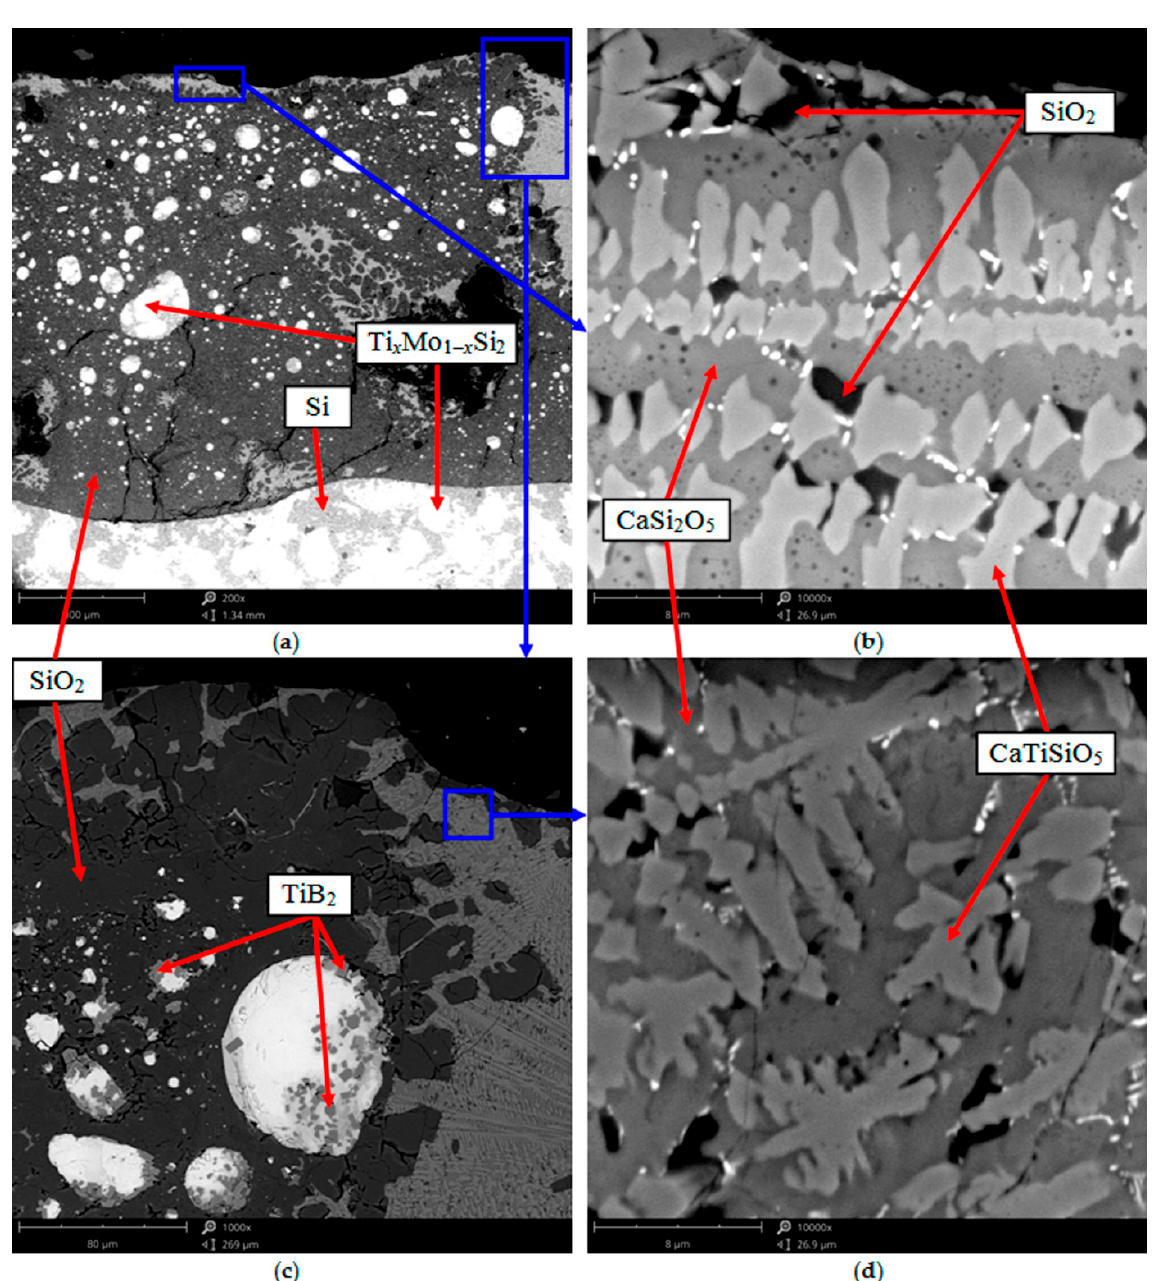
Figure 3. Microstructure of a thin section of a compact of composition 1 in the area of the surface layer after 5 h isothermal oxidation at 1650 °C in air: ( а ) ×200; ( b ) ×10000; ( c ) ×1000; ( d ) ×10000.